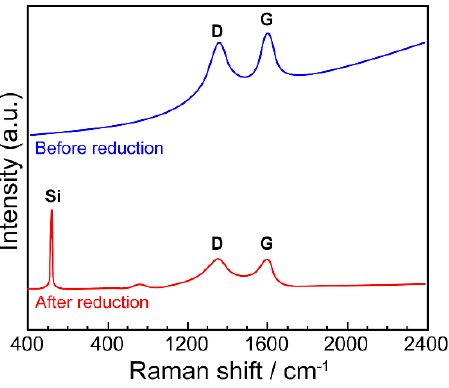
Figure 21. Raman spectra of composites before (blue) and after (red) magnesiothermic reduction.